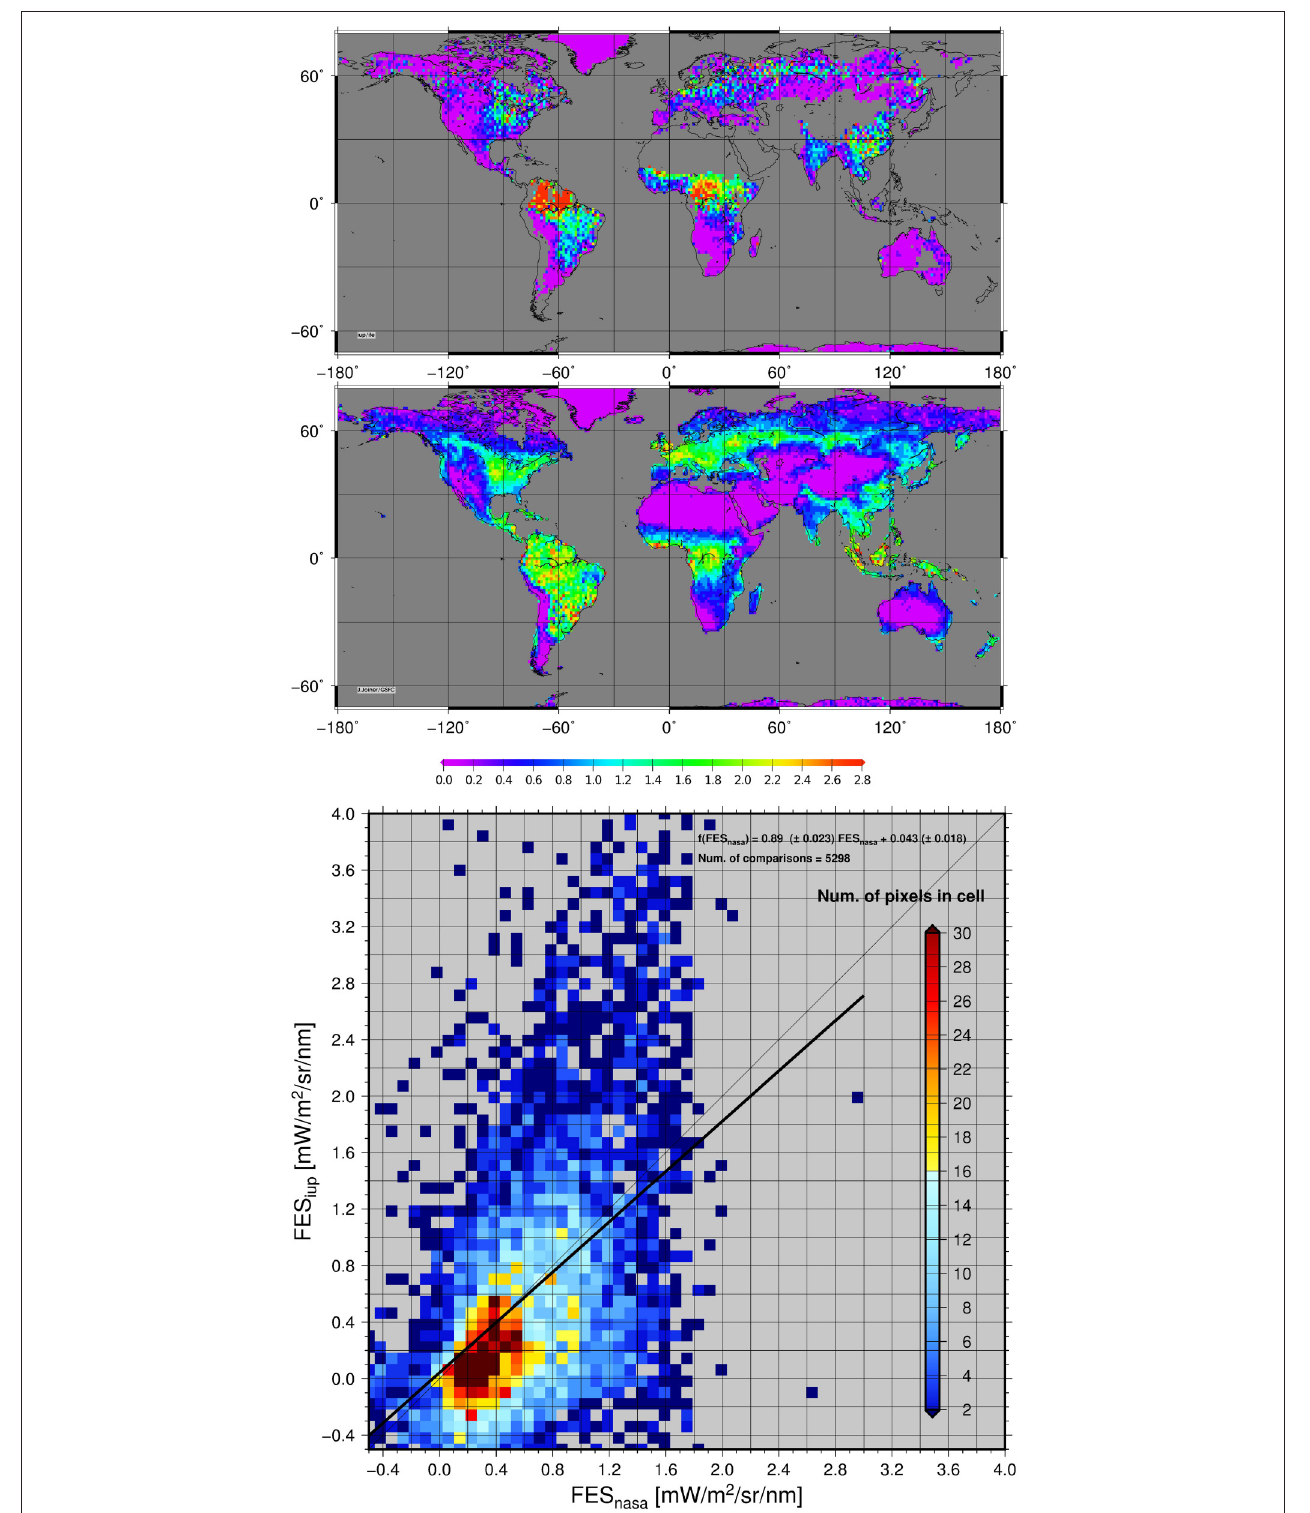
FIGURE 7 | Global values of fluorescent emission strength in [mW m − 2 sr − 1 nm − 1 ] at the top of canopy layer for the year 2009. Upper: results of this work, Middle: as reported in Joiner et al. (2013) (NASA), Bottom: a scatter (density) plot of both data sets with underlying color code (from dark red: frequent occurrence to dark blue: less